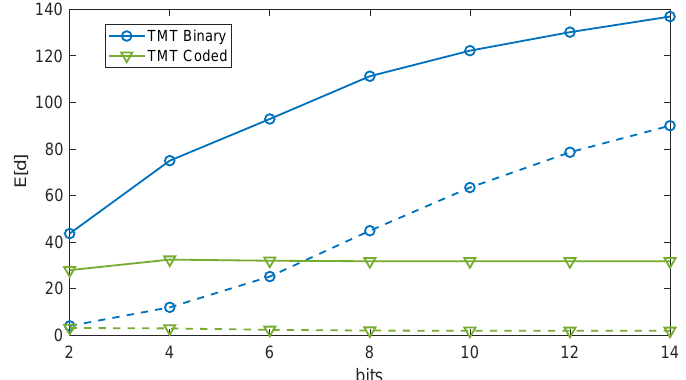
Figure 13. E [ d ] of the keys computed by Alice, Bob, and Eve for different quantization bits and arranging methods, with N = 340. Solid and dashed lines refer to the Alice-Eve and Alice-Bob links,